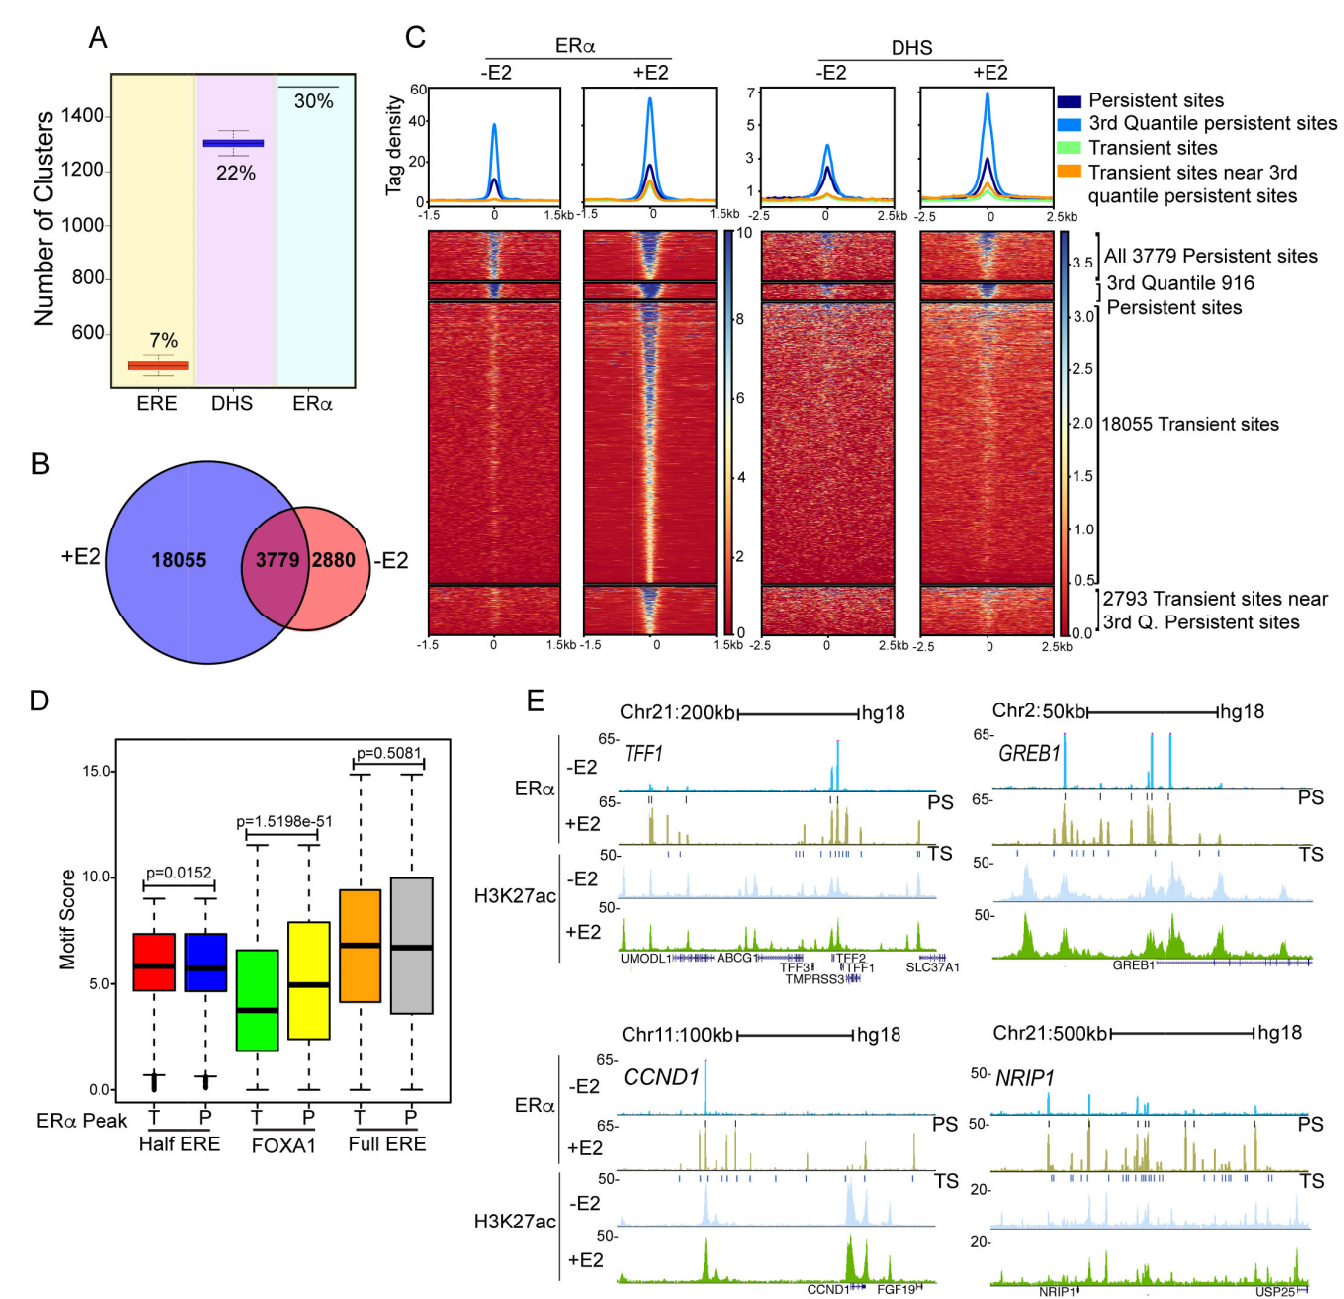
Fig 1. Estrogen receptor binds in clusters around pre-existing ER α -bound sites upon ligand stimulation. (A) ER α shows highest propensity for genomic clustering compared to ERE and DHS. Y-axis represents the number of clusters with at least 3 sites (ER α , ERE, or DHS individually) with less than 20kb between consecutive sites. (B) Venn diagram showing 3779 persistent ER α peaks being common in control and E2 treated cells. (C) Heat map exhibiting binding strength of ER α (left panel), and DHS (right panel) on all persistent, strongest persistent (3 rd quantile), all transient, and transient sites clustered around a persistent site. (D) Motif enrichment plot showing relative scores of Half ERE, FOXA1 and Full ERE motifs in transient and persistent sites. (E) UCSC genome browser snapshots showing the binding of ER α and H3K27ac status on ER α clustered enhancers for four of the robustly E2-induced target genes– TFF1 , GREB1 , NRIP1 , and CCND1 in unliganded and in E2 conditions. The boxplots depict the minimum (Q1-1.5 � IQR), first quartile, median, third quartile and maximum (Q3+1.5 � IQR) without outliers.